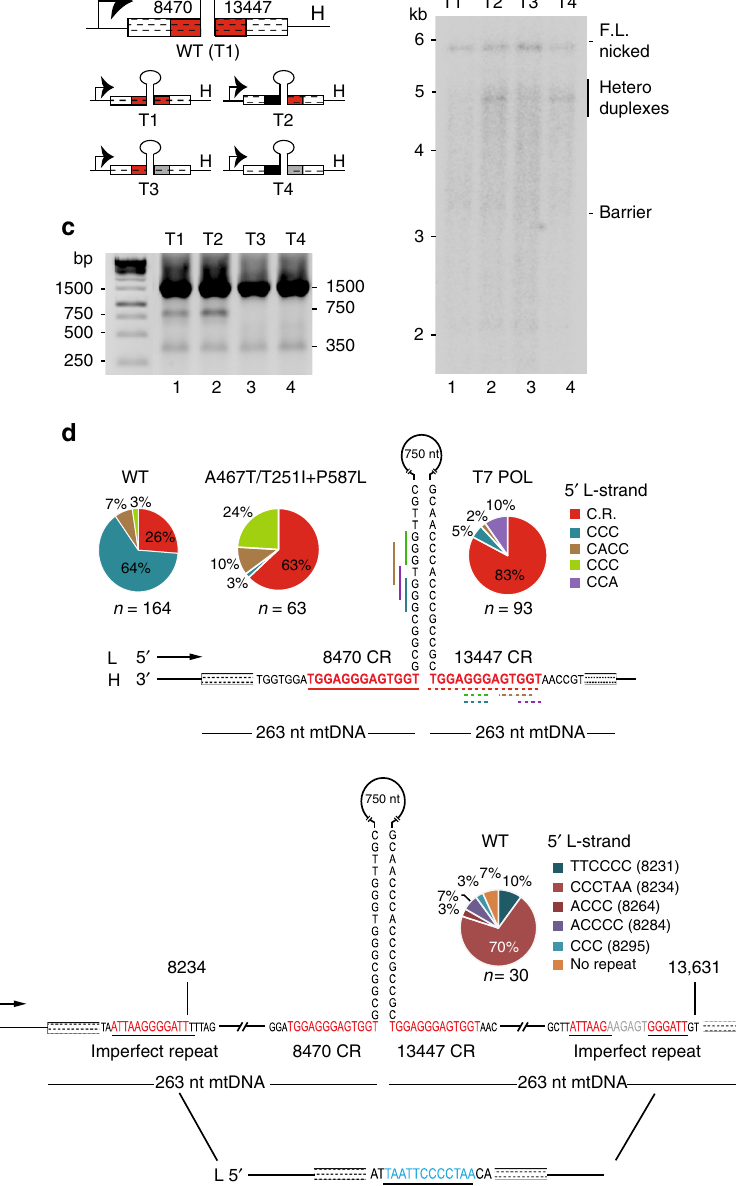
Fig. 3 Deletion formation between direct repeats. a Mutation analysis of 8470-CR and 13447-CR. Barrier templates were used with wild-type repeats (T1); or with mutations in 8470-CR (T2); 13447-CR (T3); 8470-CR and 13447-CR (T4). b L-strand DNA synthesis using the T1-T4 templates. c The reactions in panel b analysed by PCR. d Breakpoints identi fi ed at the replication barrier (750-bp product) using wild-type; a mixture of POL γ :A467T and POL γ :T251I + P587L; or T7 DNA polymerase. The H-strand sequence is shown and the various location of repeats at breakpoints are indicated in colour code ( fi rst repeat solid line, second repeat dashed). The frequency of each different breakpoint is indicated in the pie chart. Please note, the short repeat sequences next to the pie chart are shown as the L-strand sequences. e The majority (70%) of breakpoints identi fi ed for the 350-bp product using POL γ wild-type were localized